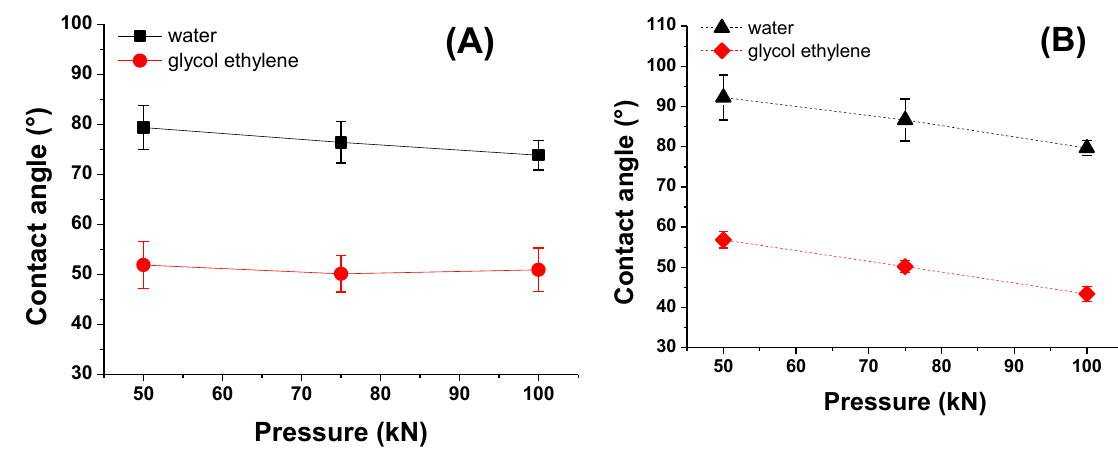
Figure 11. Contact angle vs. laminating pressure of ( A ) PAN; ( B ) PVDF multilayer nanofibrous membranes.